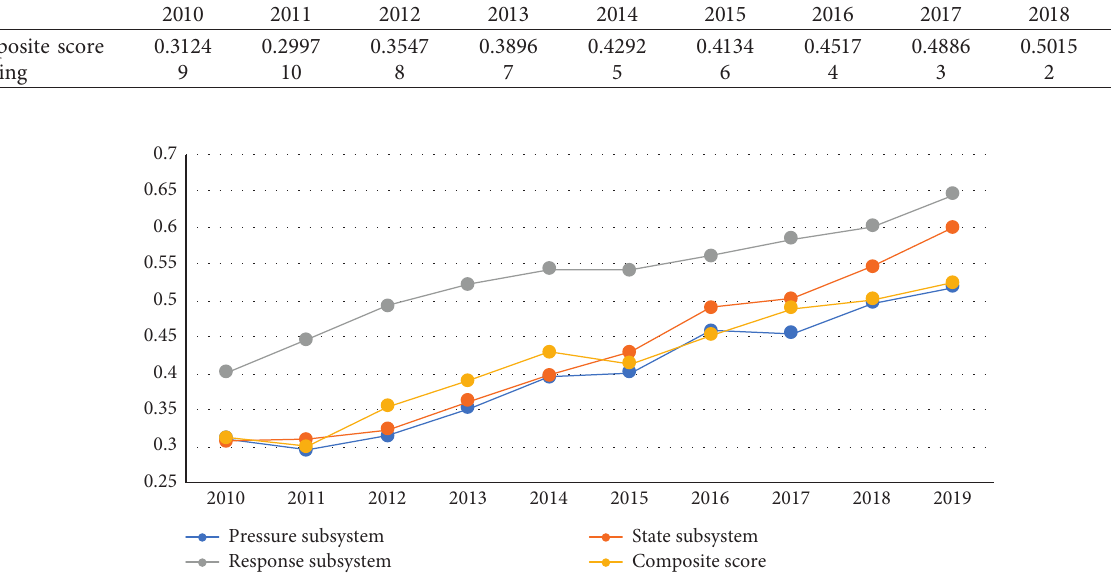
Table 3: Composite scores of the YREB WECD level in 2010–2019.